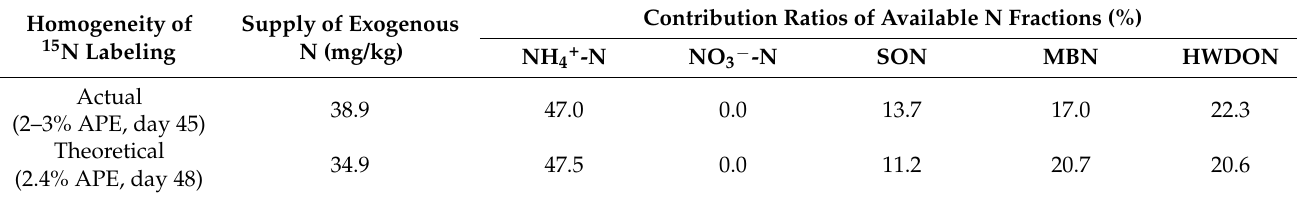
Table 3. Supply of exogenous N and contribution rates of available N fractions; SON, soluble organic nitrogen, MBN, and microbial biomass nitrogen; HWDON and hot-water extractable organic N. Homogeneity of Supply of 15 N Labeling